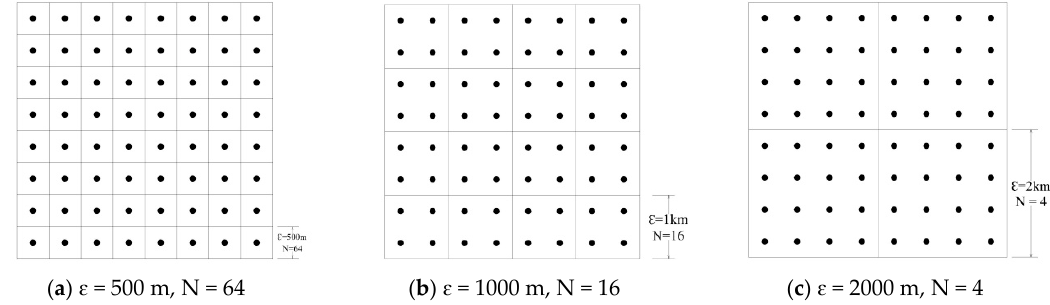
Figure 2. Grid division of the study area.